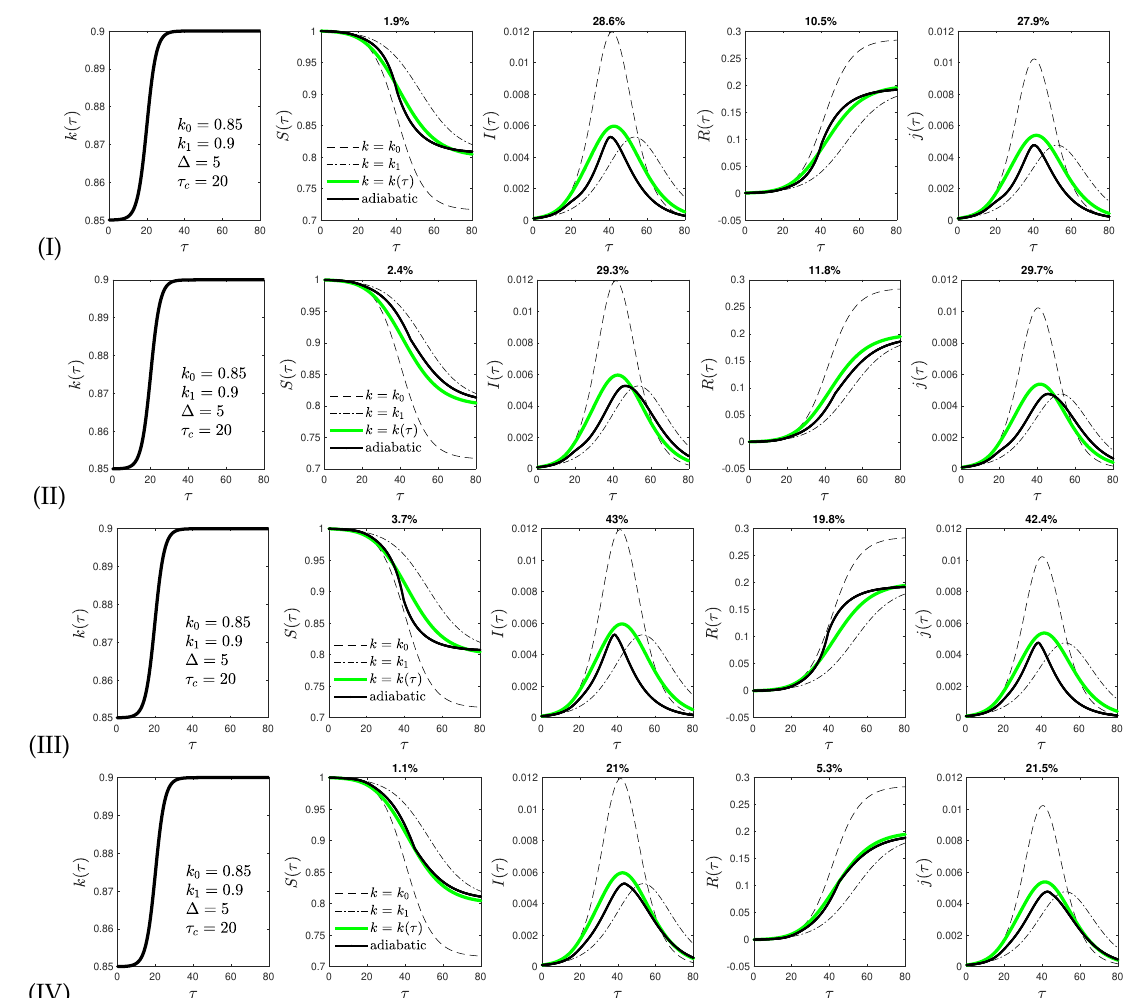
Figure 4. Same as Figure 2 but with another set of the parameters ( k 0 = 0.85, k 1 = 0.9, ∆ = 5, and τ c = 20) of the ratio k ( τ )